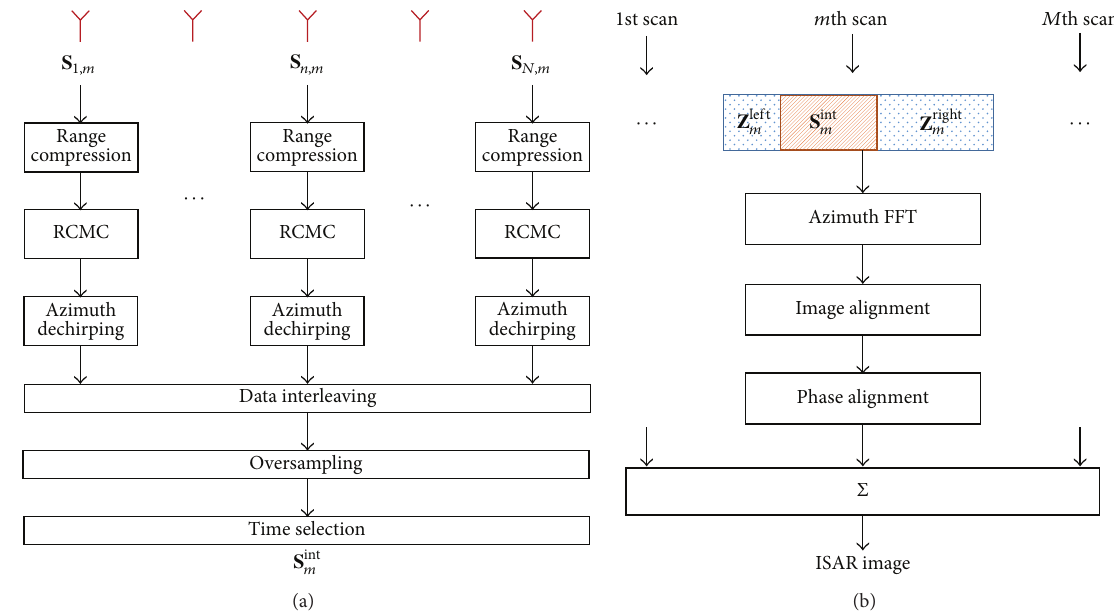
Figure 5: Processing scheme: (a) single-scan processing and (b) multiscan data fusion.